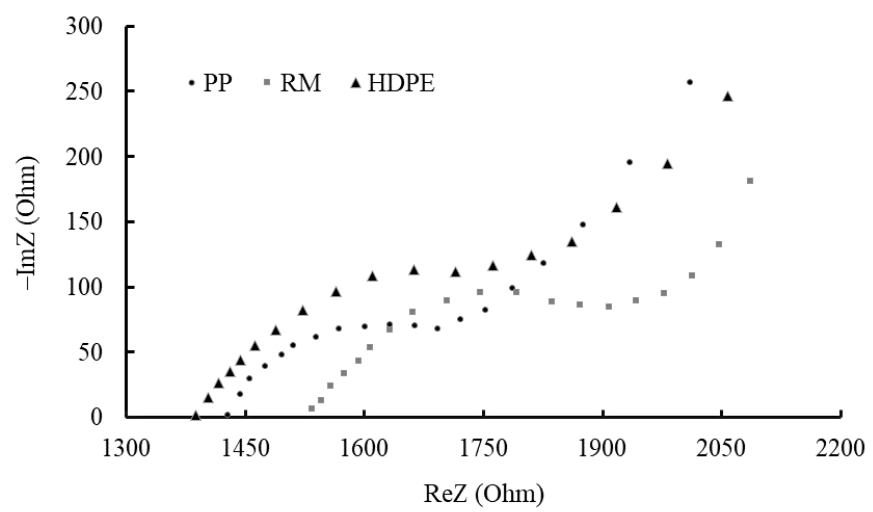
Figure 10. Nyquist plots of each category of reinforced concrete specimens.